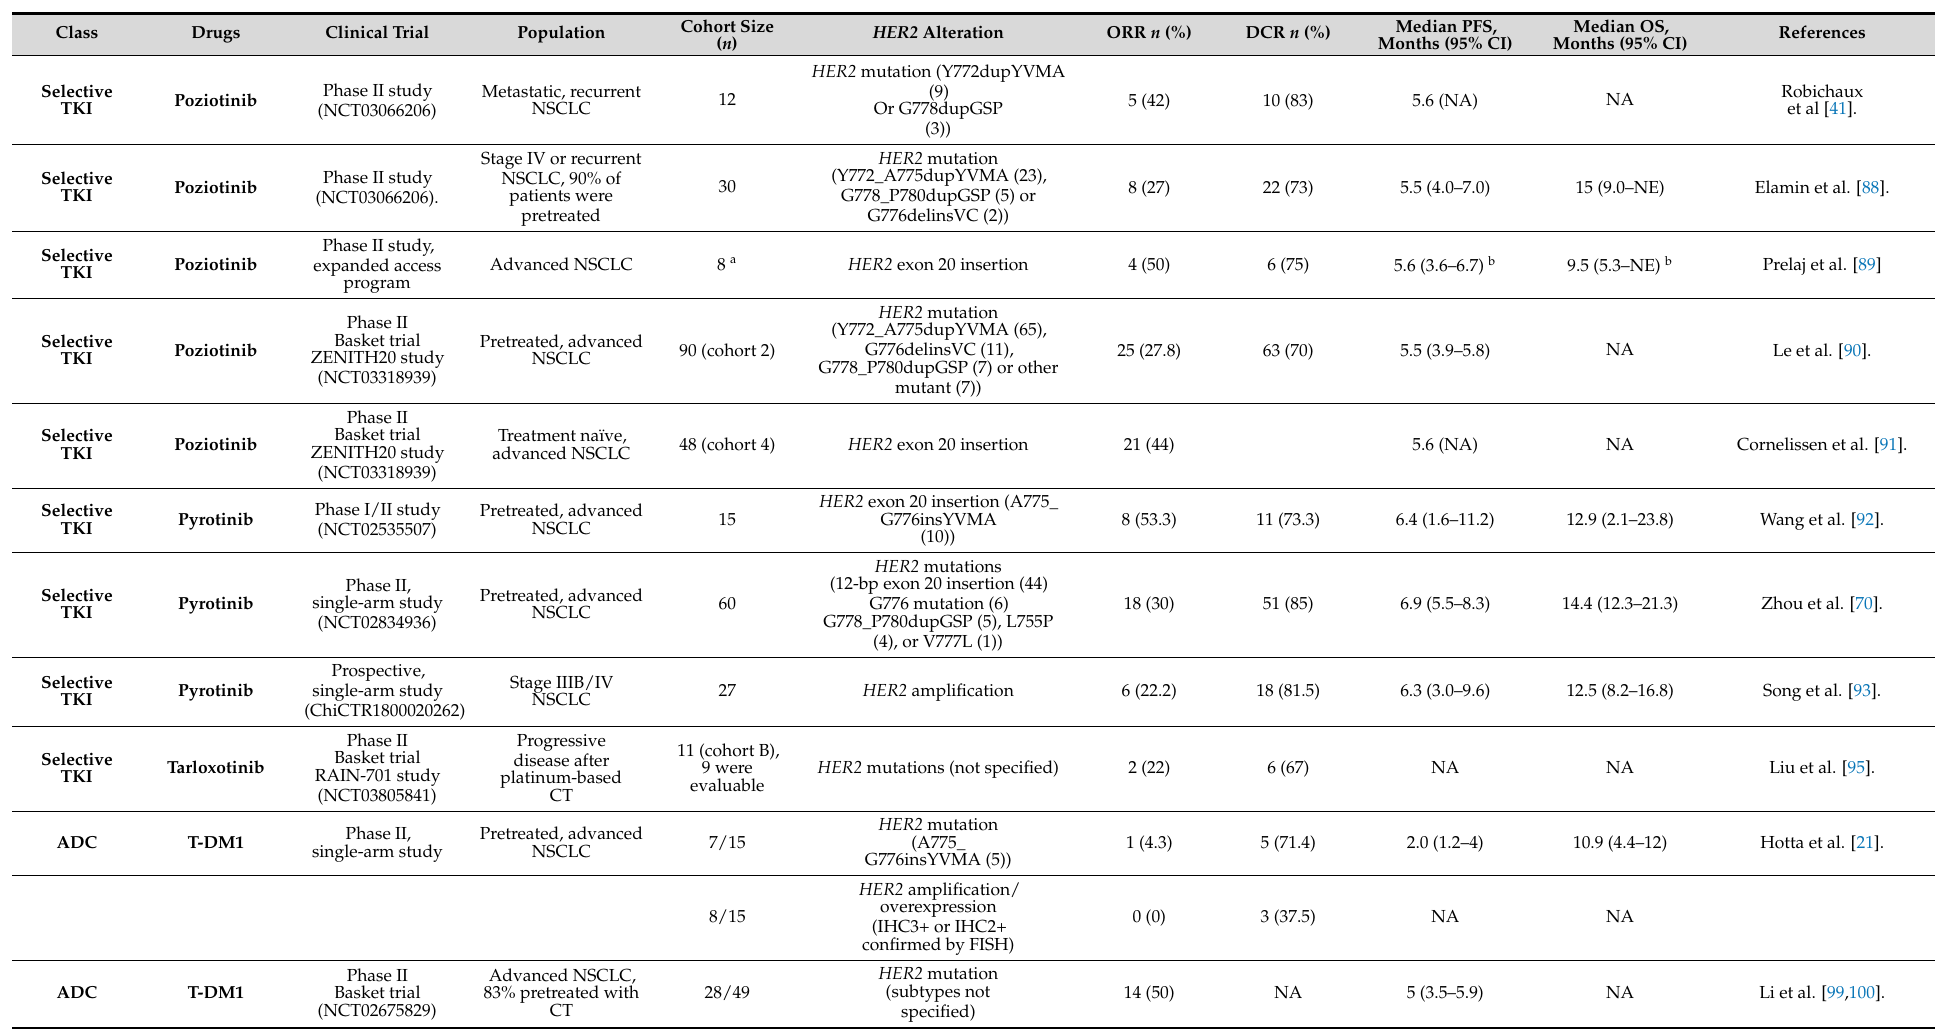
Table 2. Main clinical trials and efficacy of treatment in NSCLC patients with HER2